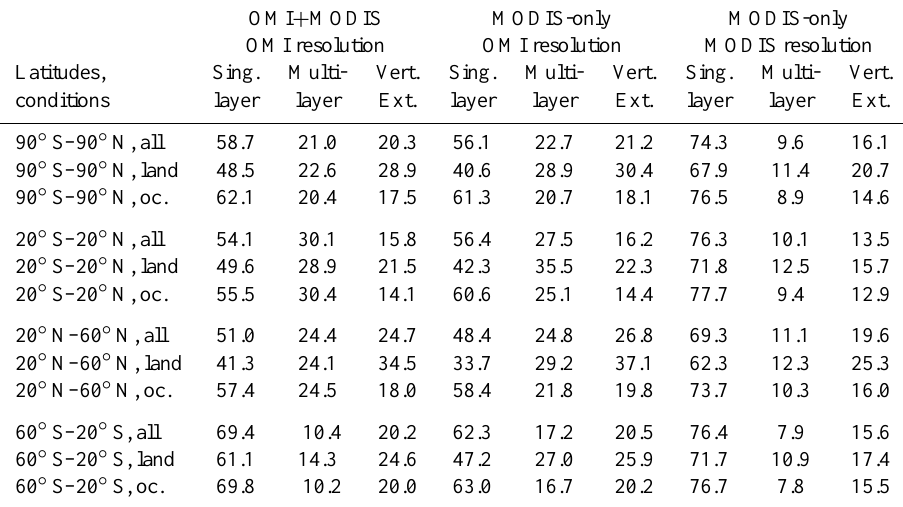
Table 4. Monthly-mean cloud classification statistics using passive sensors for July 2007 (given as % of cloudy pixels designated as either single cloud layer, distinct multiple layers, or vertically-extended) using the different passive sensor configurations- OMI/MODIS on the OMI footprint (left 3 columns), MODIS-only on the OMI footprint (middle 3 columns), or MODIS-only at 5km × 5km resolution (right 3